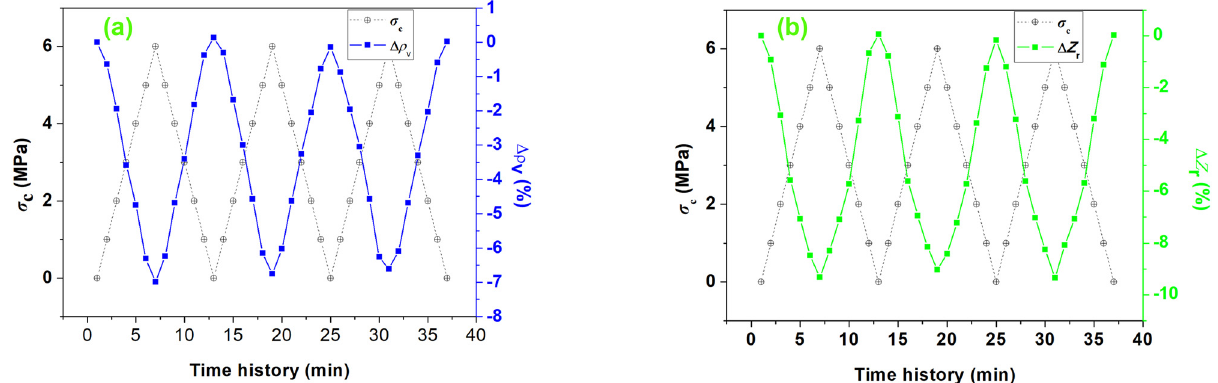
Figure 7: The piezoresistive curves of MNTSM: ( a ) Δ ρ v − σ c relation; ( b ) Δ Z r − σ c